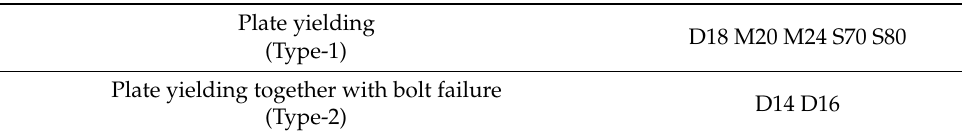
Table 4. Failure modes for test specimens.